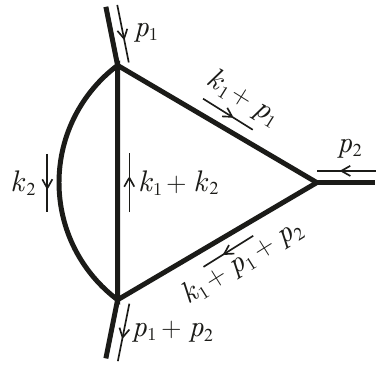
Figure 1 . The two-loop three-point graph considered in the